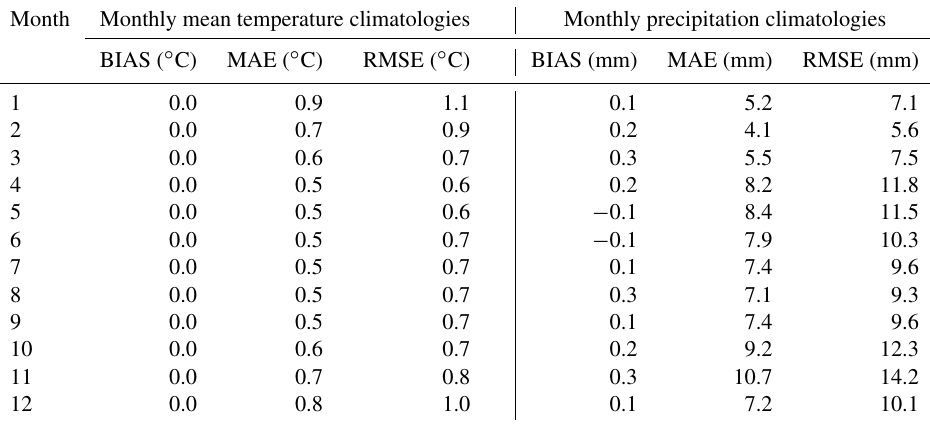
Table 2. Monthly mean leave-one-out reconstruction errors of the 1981–2010 monthly mean temperature and precipitation climatologies for Trentino-South Tyrol sites. BIAS is computed as the difference between simulations and